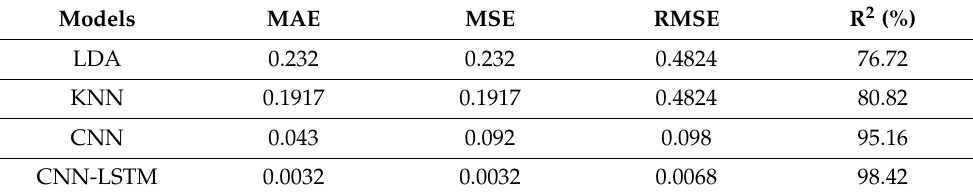
Table 8. Statically analysis.